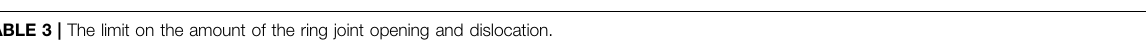
TABLE 3 | The limit on the amount of the ring joint opening and